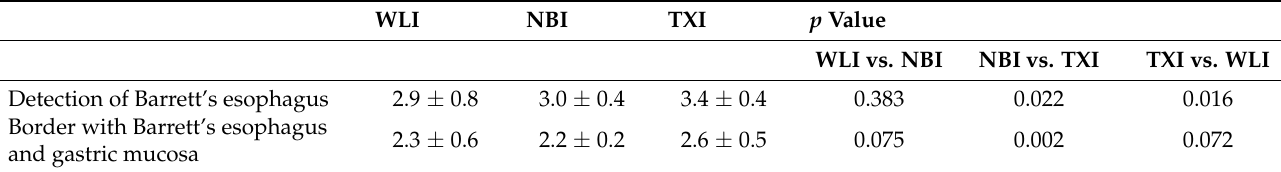
Table 4. Visibility assessment of Barrett’s